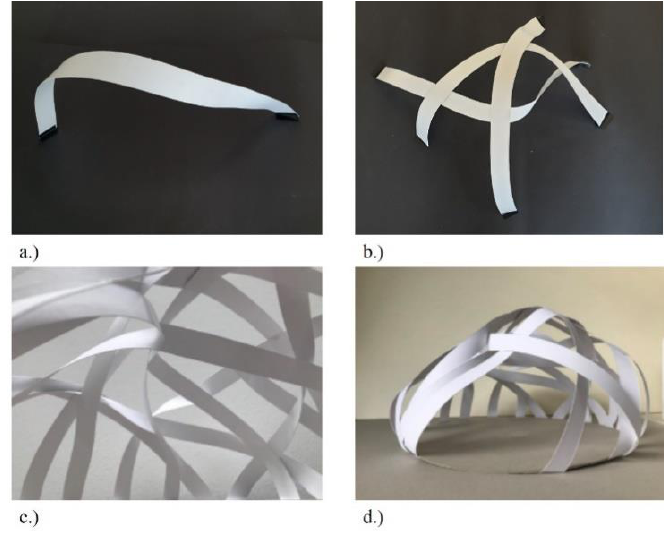
Fig. 5 Design concept as paper